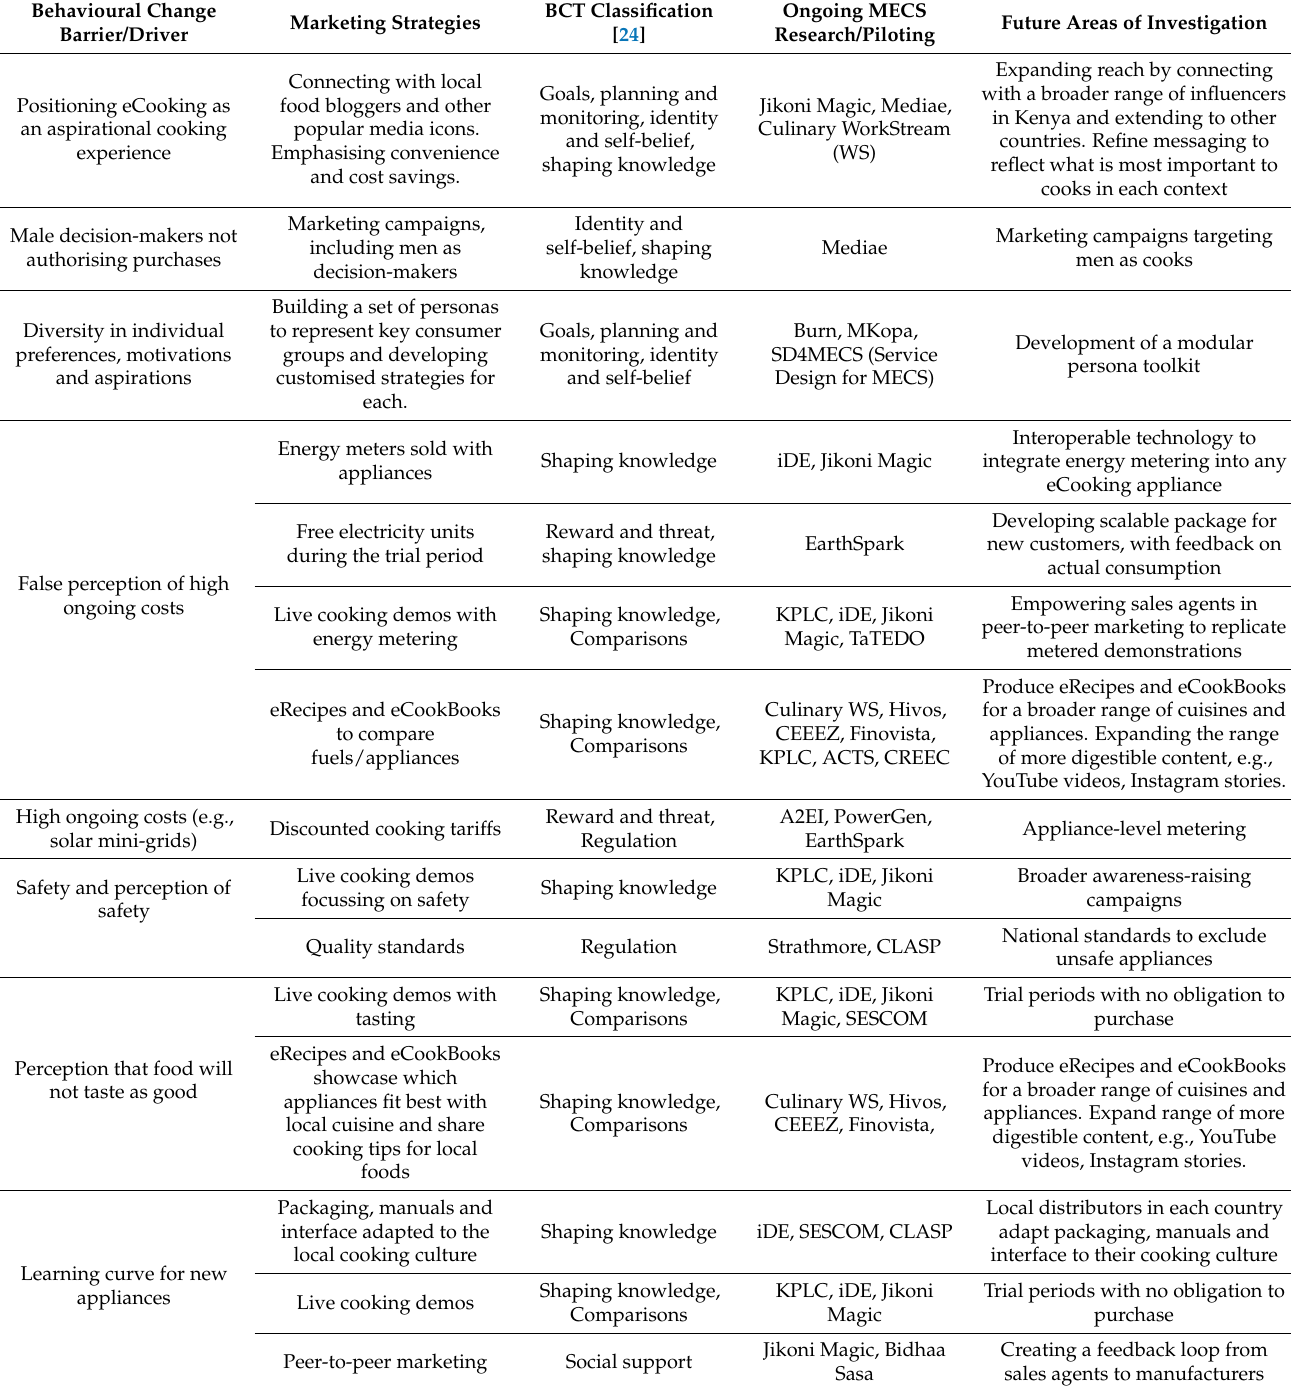
Table 3. Summary of innovative marketing strategies developed by MECS partners to overcome behavioural change challenges and leverage the drivers. See Appendix A for further detail on BCT classifications